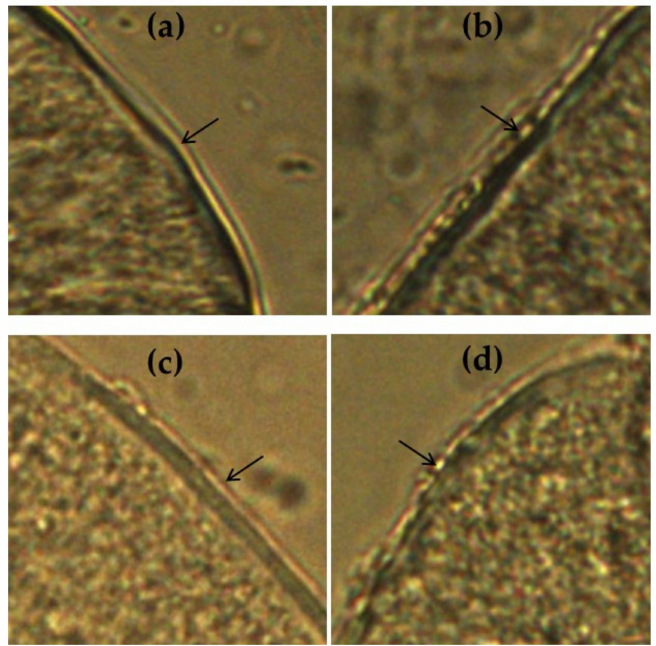
Figure 6. Inhibition of F18 + and F4 + E. coli adhesion to F18R + and F4R + piglet microvilli by anti-FedF or anti-FaeG Nbs expressing L. lactis . ( a ) Complete adhesion inhibition of F18 + E. coli (107/86) to F18R + microvilli by L. lactis (pEXP362) expressing anti-FedF NbFedF6 on its surface. ( b ) Inhibitory effect of anti-FedF Nb expressing L. lactis was blocked by pre-incubating with 50 µ g of FedF that neutralized surface displayed NbFedF6. ( c ) Partial inhibition of F4 + E. coli (C95-72) adhesion to F4R + microvilli by L. lactis (pEXP368) expressing anti-FaeG Nb V4. ( d ) Adhesion inhibition was reversed by pre-incubating L. lactis with 50 µ g of FaeG. The arrow points to the villi surface without bound E. coli ( a , c ) and with bound E. coli cells ( b , d